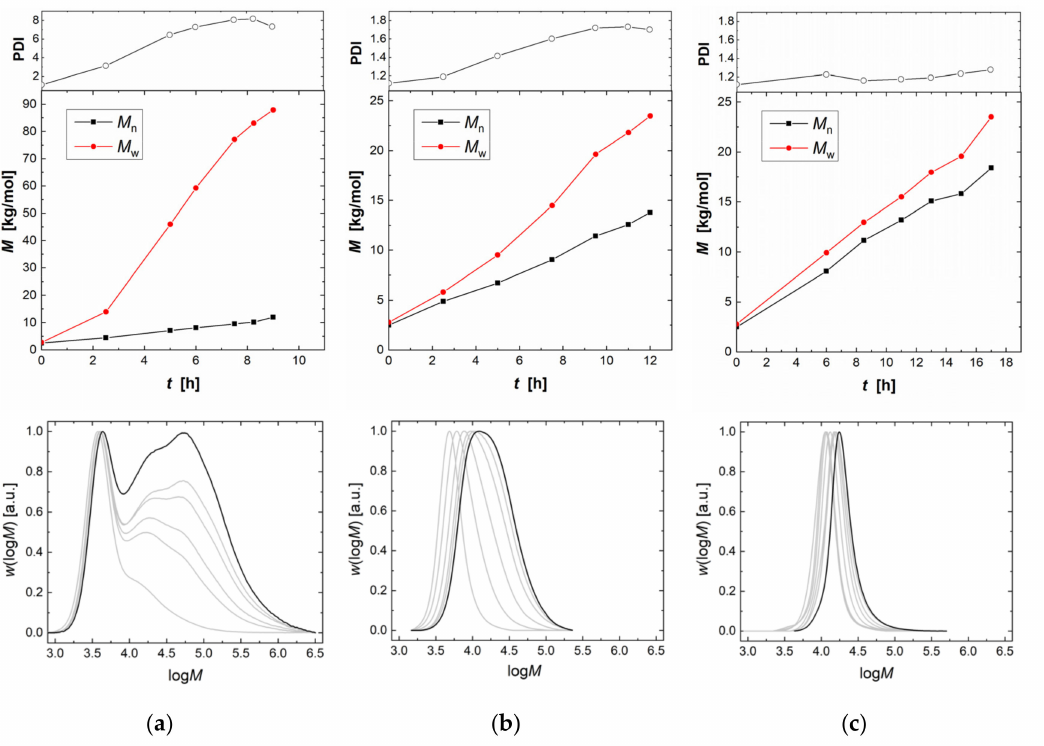
Figure 6. SEC analysis of PPECs synthesized at T = 90 ◦ C, p = 10 bar ( a , Entry 21) and T = 120 ◦ C, p = 10 bar ( b , Entry 22) and PPG at T = 120 ◦ C ( c , Entry